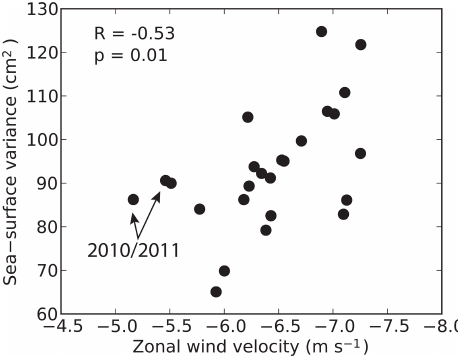
Figure 15. Year-averaged sea-level variance and coastal zonal wind velocities. Sea-surface spatial variance is obtained from daily sea- level anomaly fields from the years 1993–2017 from satellite al- timetry (CMEMS) and averaged over the interior of the Caribbean Sea (12–17.5 ◦ N, 65–75 ◦ W). Coastal zonal winds in the upwelling region (10–12.5 ◦ N, 65–75 ◦ W) are obtained from the years 1993– 2017 from the ECMWF (ERA-Interim; Dee et al., 2011). Each dot represents one